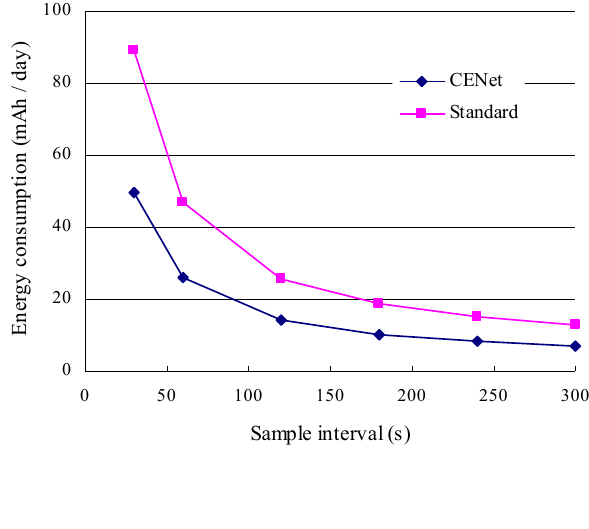
Figure 14. Average energy consumption of CENet and standard stack for sample interval between 30 s and 300